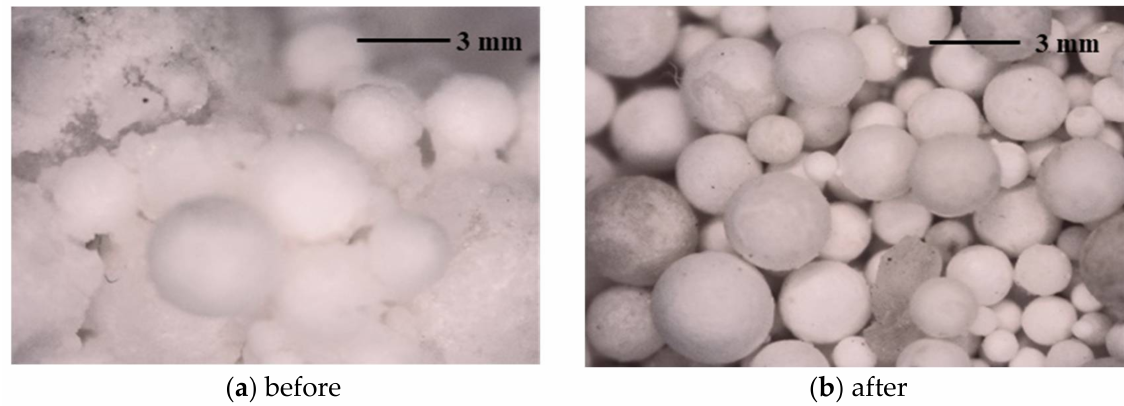
Figure 9. The cementation of proppant particles before and after the secondary adhesion.